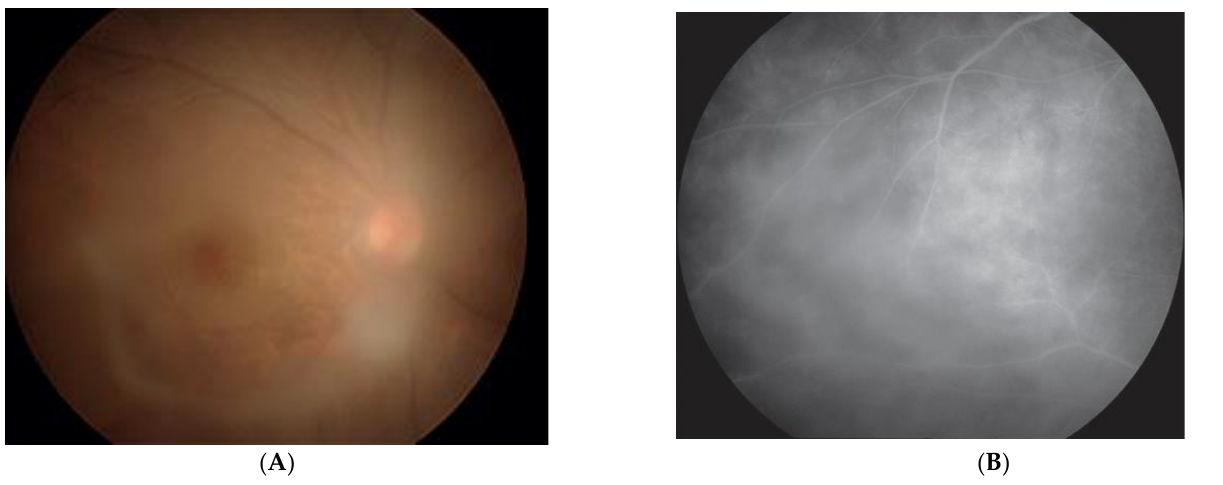
Figure 2. HU occurred after methimazole treatment following the onset of Graves’ disease. ( A ) Vit- reous opacity is seen in the right eye. ( B ) Retinal vasculitis can be seen by fluorescein angiography (Reproduced with permission from Kamoi et al., Lancet. 2022 [43]).